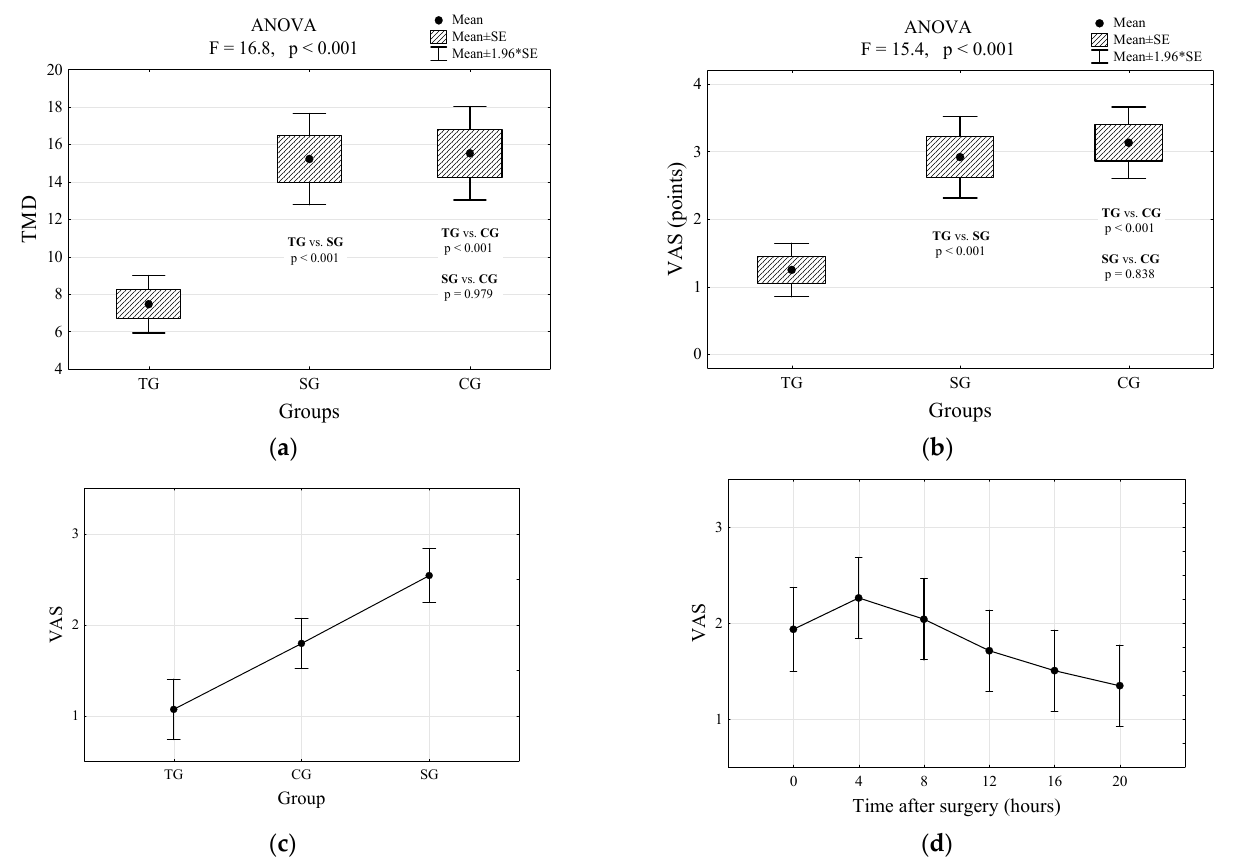
Figure 3. Differences in values of the level of perceived pain between enrolled participants: ( a ) Total dose of morphine consumed by patients with a different type of intervention and the result of the analysis of variance and multiple comparisons (Tukey’s post hoc tests); ( b ) Pain sensation assessed on the VAS scale at discharge by patients differing in the type of intervention and the result of the analysis of variance and multiple comparisons (Tukey’s post hoc tests); ( c ) Expected boundary values of the perceived pain (mean and their 95% confidence intervals) and the assessment of the impact of treatment; p < 0.00001; ( d ) Expected boundary values of the perceived pain (mean and their 95% confidence intervals) and time after the surgery; p = 0.028. TG—true group; CG—control group; SG—sham group; VAS—visual analog scale; TMD—total morphine dose in milligrams.